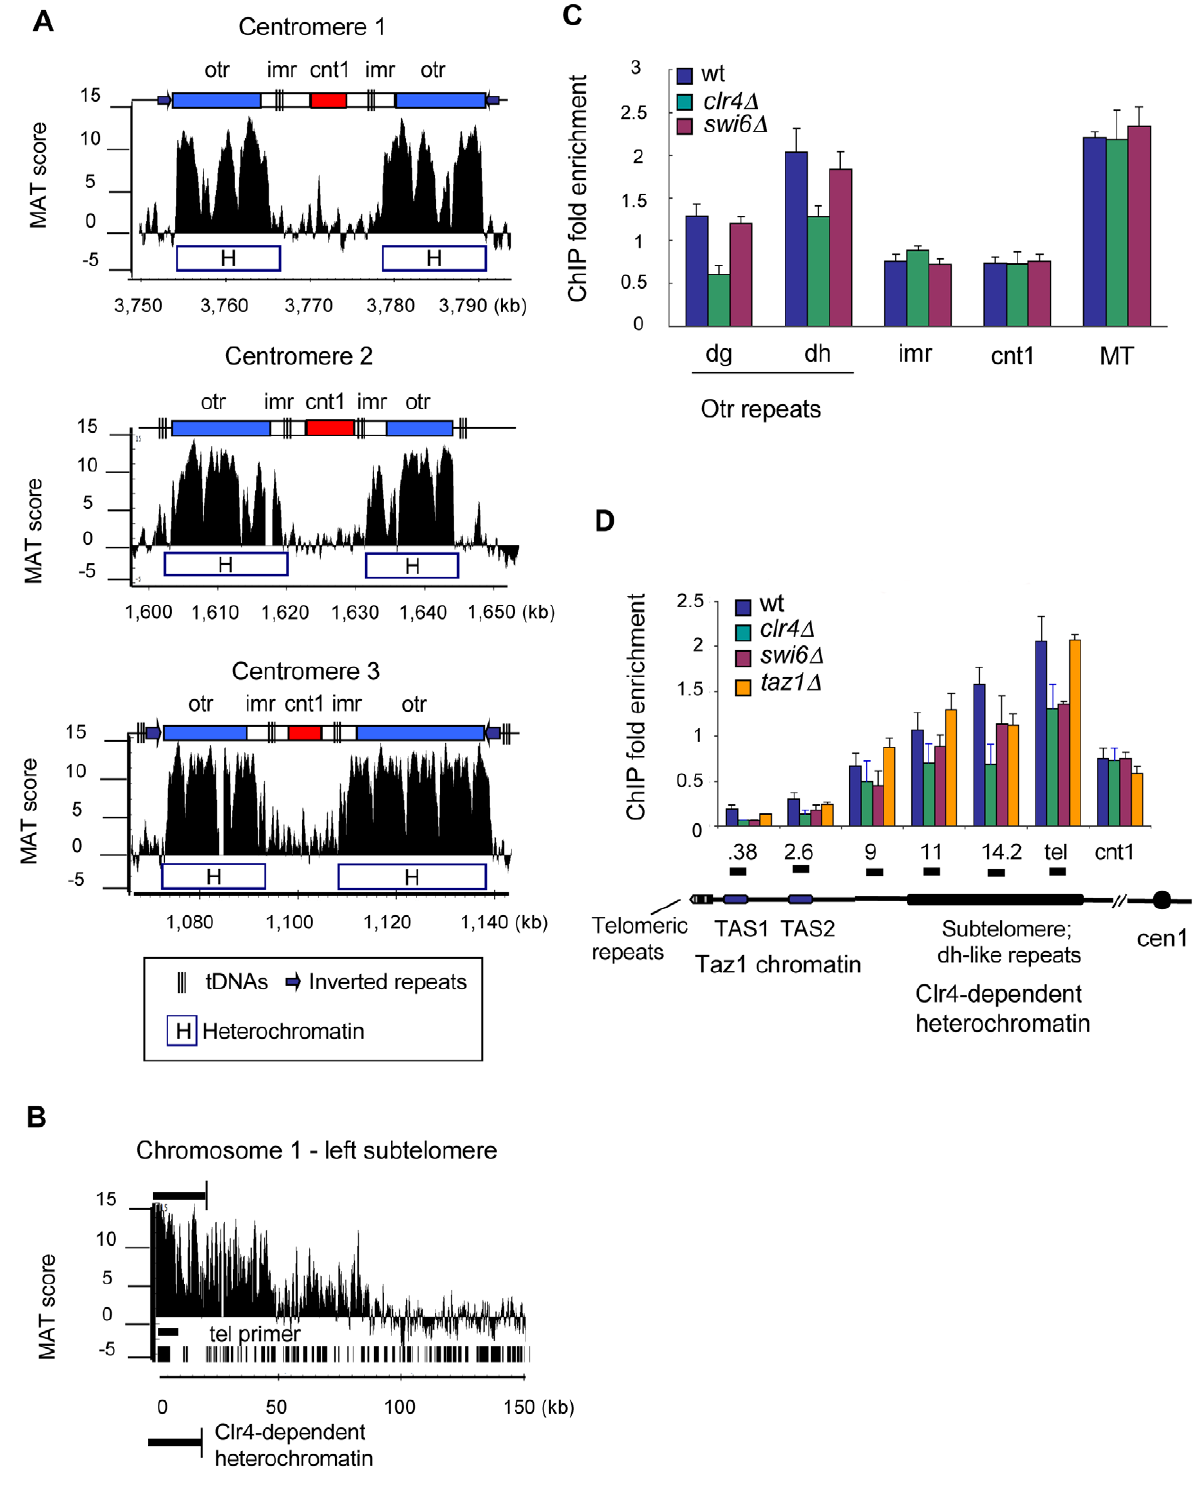
Figure 7. c H2A in the centromeres and telomeres is associated with Clr4-dependent heterochromatin. (A) Detailed ChIP-on-chip distribution of c H2A at the centromeres. Diagrams above each plot indicate key centromere features: otr – outer centromere dg/dh repeats; imr- inner repeats; cnt –centromere core. (B) Detailed ChIP-on-chip distribution of c H2A in the subtelomere of Chromosome 1. Location of genes and ‘‘tel’’ qPCR primer is shown as black bars below plot. (C) c H2A levels were reduced at the centromeres in clr4 D cells. c H2A ChIP was performed in indicated strains synchronized by cdc25-22 block. The dg and dh primers are located in the outer centromere repeats. ChIP data is shown as Fold Enrichment, which was calculated relative to the act1 gene. (D) c H2A domain in the subtelomeres colocalizes with heterochromatin and decreases in clr4 D and swi6 D cells. ChIP was performed as in (C). Diagram below graph shows the organizational structure of the telomeres (not to scale) and was based on [70]. Primer locations are marked by horizontal black bars (top) and correspond to distance in kilobases from the telomeric repeats.